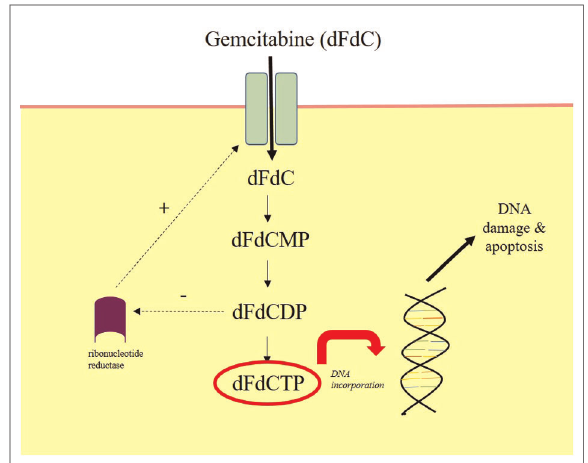
FIGURE 2 Mechanism of action of intravesical gemcitabine. Gemcitabine (dFdC) is prodrug. It moves intracellularly following intravesical administration through nucleoside transporters. It is phosphorylated by kinases into gemcitabine monophosphate (dFdCMP), gemcitabine diphosphate (dFdCDP) and fi nally gemcitabine triphosphate (dFdCTP). dFdCTP incorporates into the DNA strand and inhibits DNA synthesis, which mediates cellular apoptosis. dFdCDP also inhibits ribonucleotide reductase, which drives further dFdC uptake. Diagram redrawn from Ueno et al, 2007